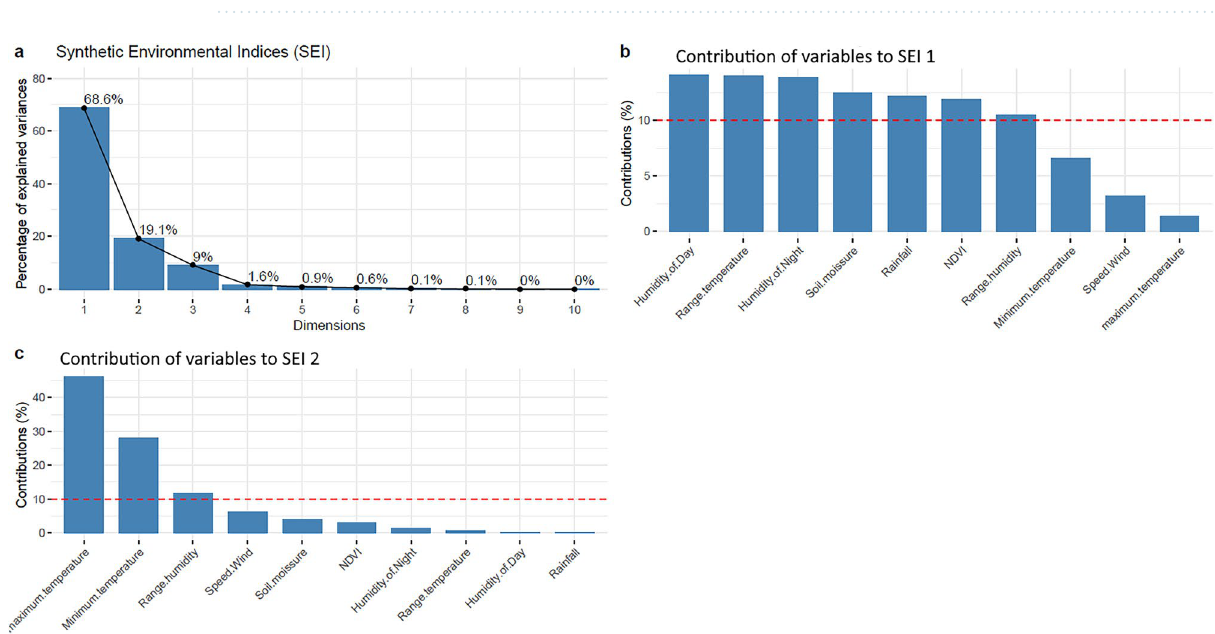
Figure 2. Malaria incidence time series, Mali, 2017–2019. Grey band: periods of high malaria transmission; Blue bars: rainfall (left y-axis, mm); Red curve: malaria incidence (y-right axis, cases/person-months); Black curve: average monthly temperature (y-right axis, °C).